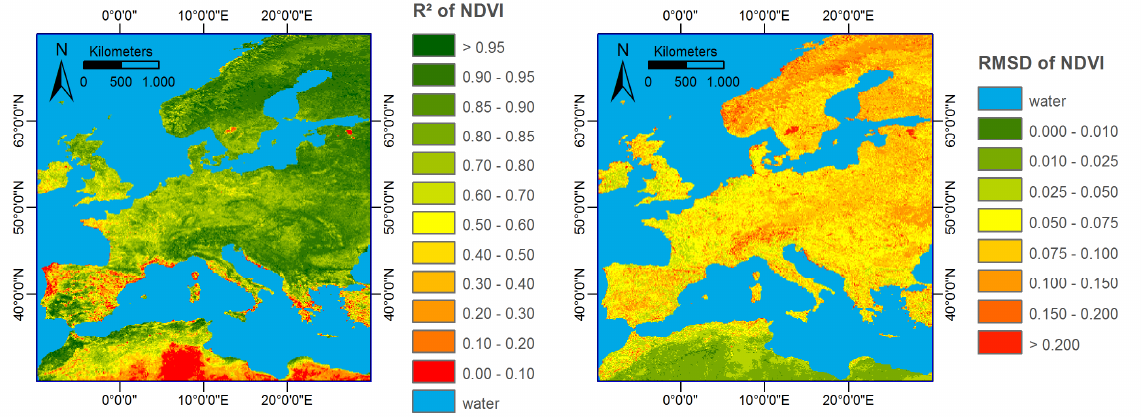
Figure 8. ( left ) Coefficient of determination (R 2 ) and ( right ) root mean square difference (RMSD) between the temporal GIMMS and MODIS series calculated across all weekly observations between 2002 and